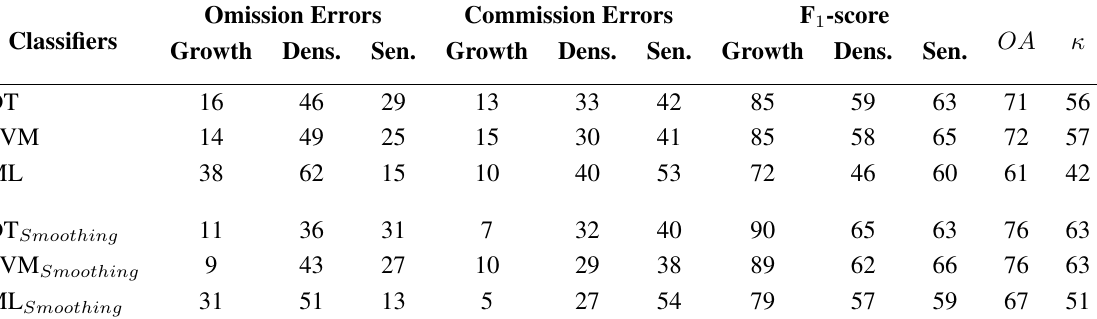
Table 4. Accuracy parameters of the three classifiers with original and smoothed data. DT, decision